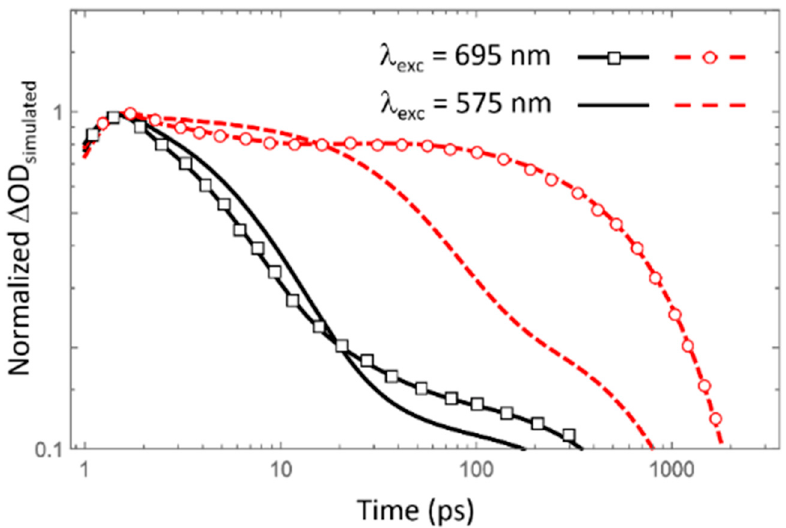
Figure 8. Numerically simulated Δ OD for different excitation wavelength cases. The black solid and the red dashed lines show the simulated decay kinetic traces for energetically higher lying bands at ~950 nm and lower lying bands at ~1300 nm, respectively.